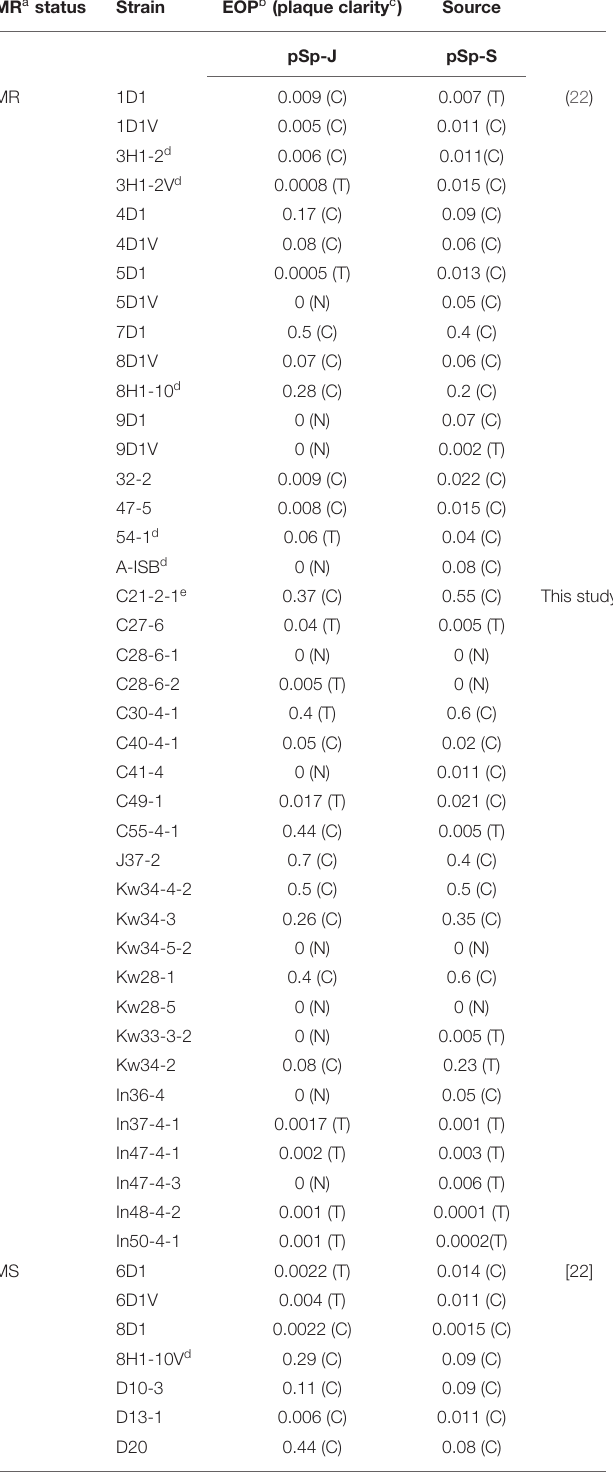
TABLE 1 | Host range of phage pSp-J and pSp-S against S. pseudintermedius strains used in this